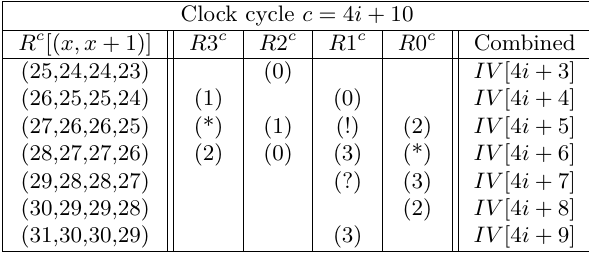
Table 6: Bit relations learnt from introducing differences at IV [4 i + j ] where j = { 0 , . . . , 4 } . The first column denotes the indices of each shift registers. ( j ) denotes the relations obtained from having difference at IV [4 i + j ]. (!), (?) and (*) denote derived relation from multiple sources. The “Combined” column denotes the difference position in the IV to obtain the 4 combined bit relations.